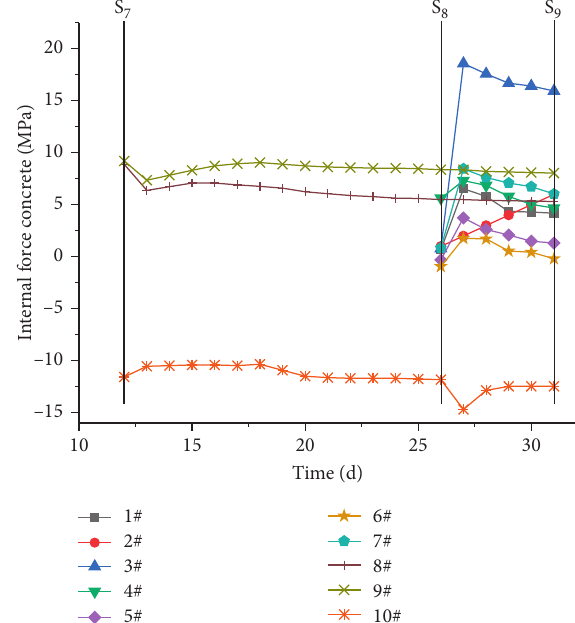
Figure 16: DK-190+645 mileage concrete internal force change curve of Zaosheng